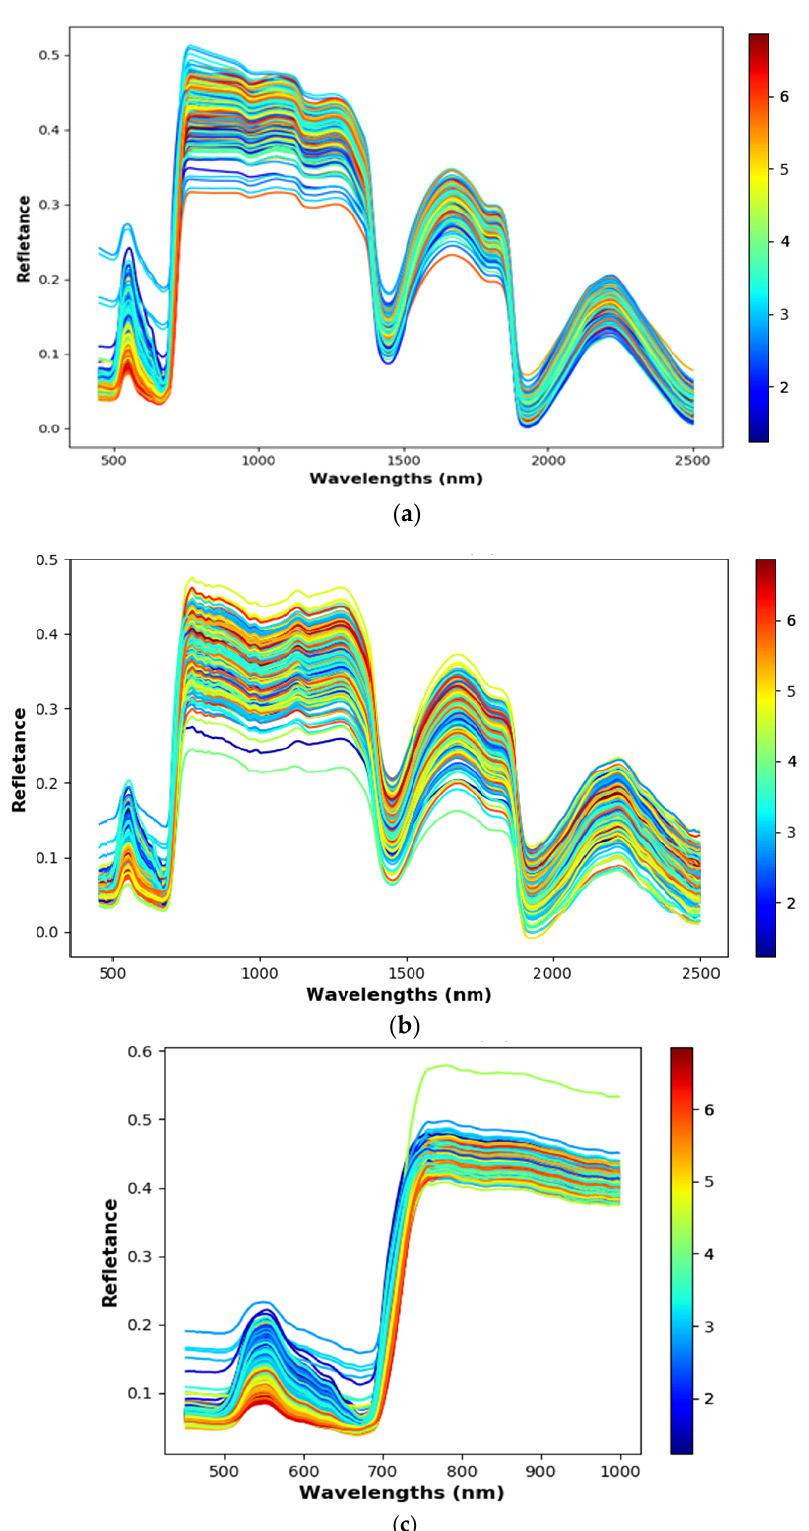
Figure A1. Data collection. ( a ) Data collection using the ASD Spec 3 spectrometer. ( b ) A wheat leaf bound to a leaf ‐ bed for imaging. ( c ) The system set up of the hyperspectral imaging system in the phenotyping platform. The larger camera on the top is the SWIR camera and the smaller camera on the bottom is the FX10 camera. ( d ) The system set up of the labscanner using the FX10 camera. ( e ) The leaves bound to the leaf ‐ beds and laid on the conveying tray of the labscanner for imaging.